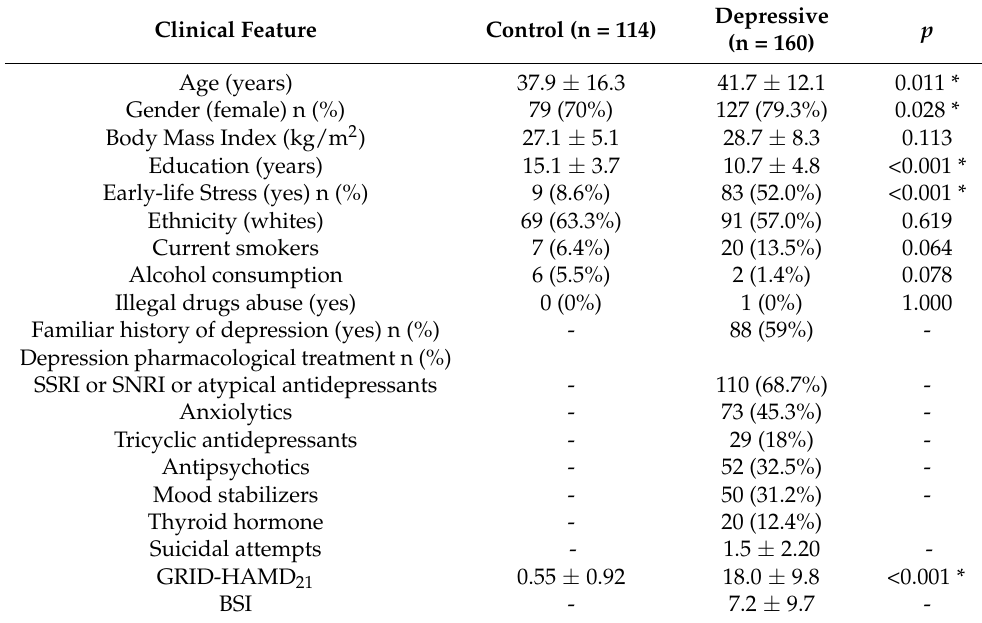
Table 1. Clinical characteristics of control and depressive